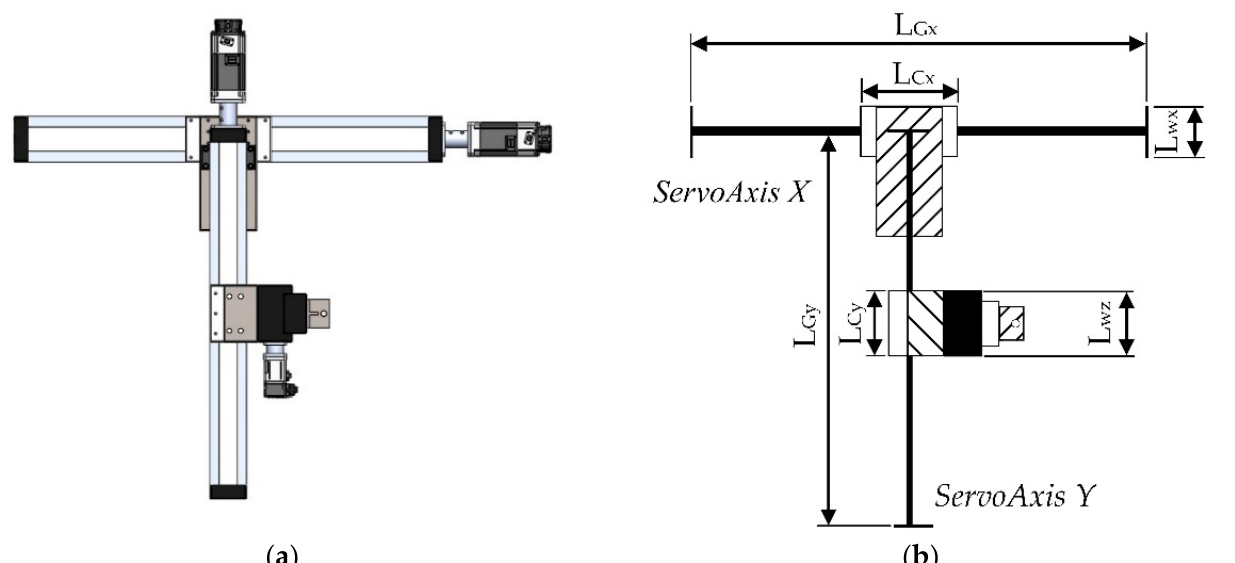
Figure 11. Top view. ( a ) 3D Version. ( b ) MMCS version.